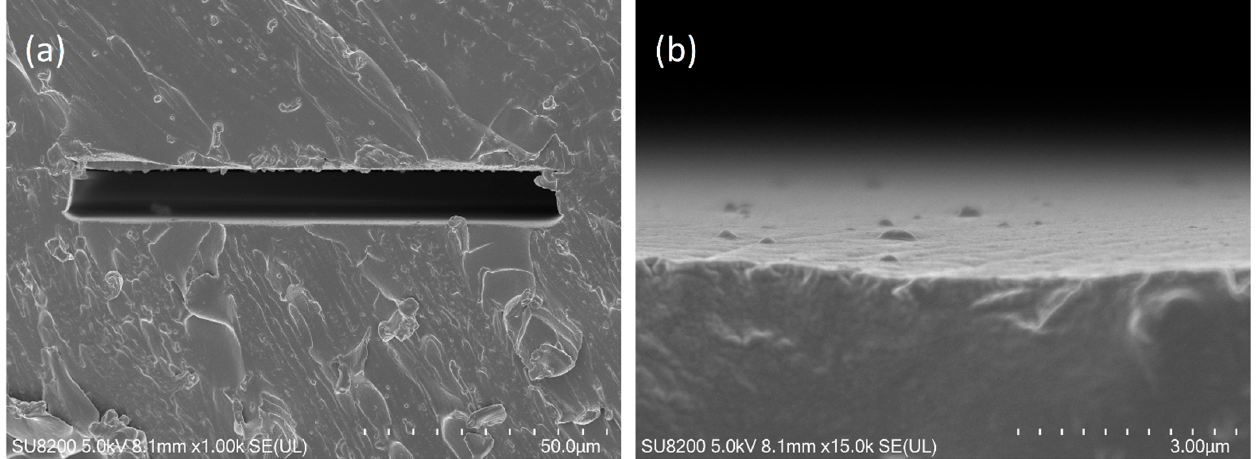
Figure 7. Images of a 100- µ m-wide microchannel in a PDMS:PDMS structure taken using a Hitachi SU-8230 SEM, showing a cross-section of the entire channel ( a ) and a close-up on the central part of the bottom surface of the channel (which was exposed to the oxygen plasma during the bounding process) ( b ).